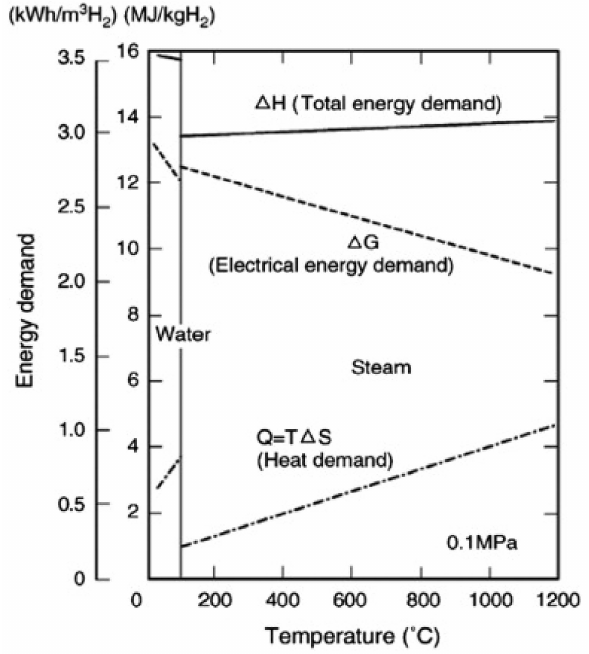
Figure 4. Water and steam electrolysis energy demand [57]. Reproduced with permission from Elsevier,